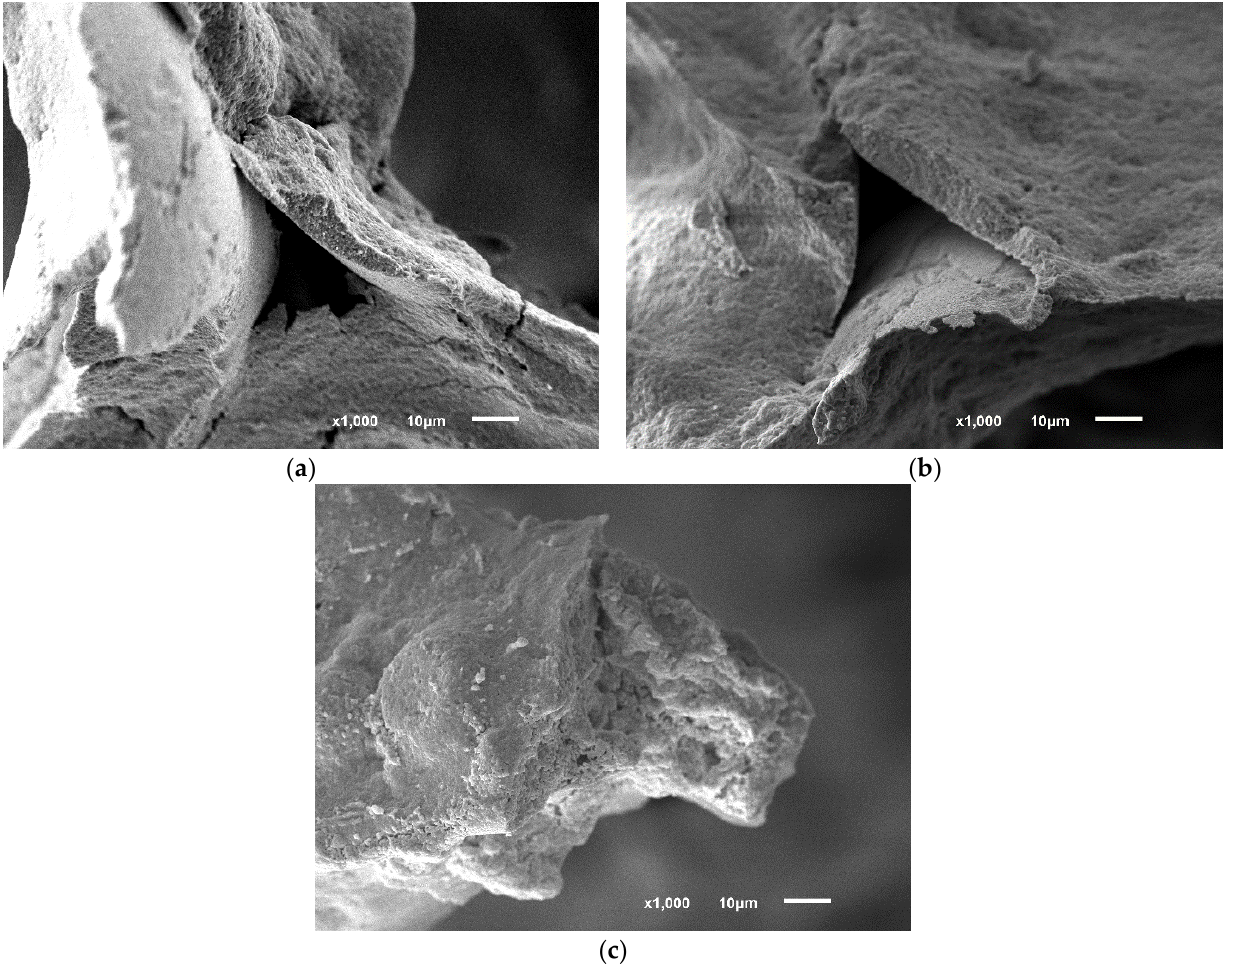
Figure 10. SEM image of ( a ) a fractured strut wall of reticulated porous coated with zirconia once, ( b ) thick reticulated porous coated with zirconia twice, and ( c ) a filled strut wall of reticulated porous coated with zirconia three times.